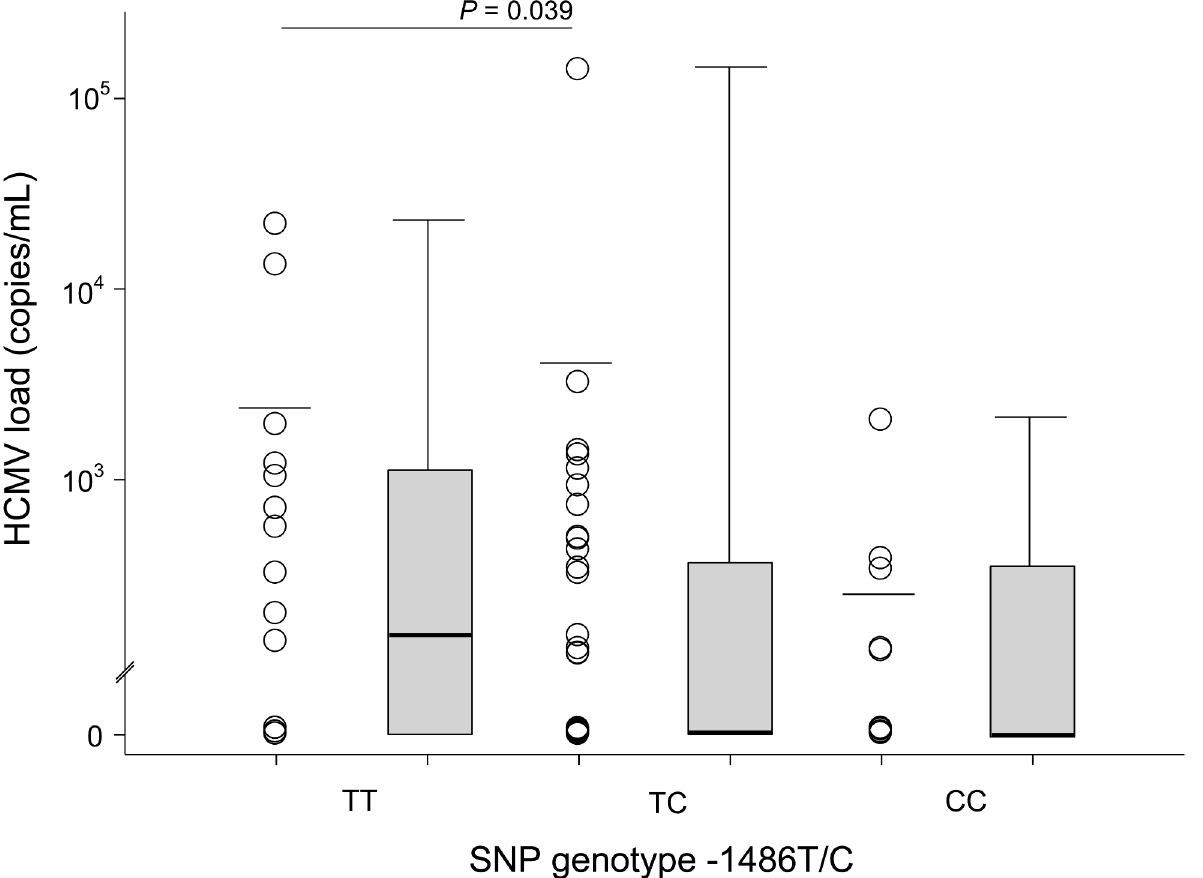
Fig 2. Comparison of viremia levels in HCMV-infected infants without or with the TLR9 -1486T/C SNP (N = 72). Bars in the scatter dot plot represent the mean viral loads. Bars in the box plots represent median viral loads, upper and lower borders represent the 25th and 75th percentiles, and whiskers represent the minimum to maximum values. P (cid:1) 0.05, Mann-Whitney U test.